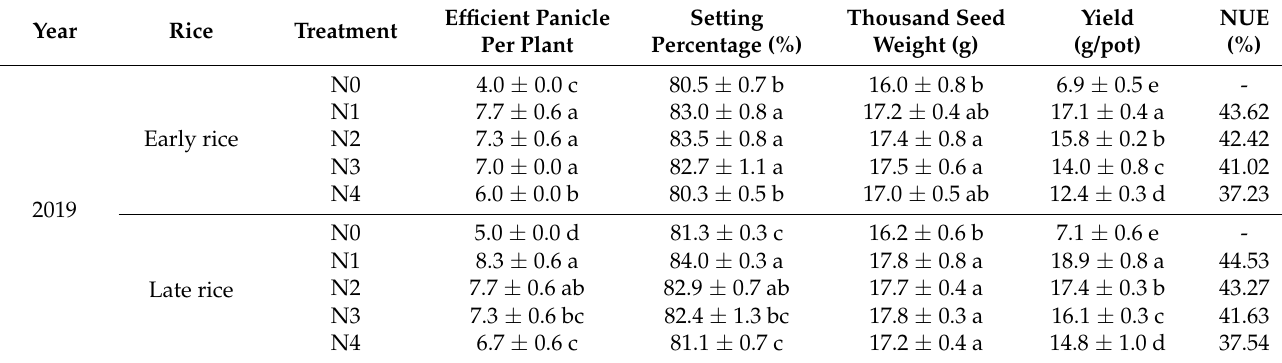
Table 1. Effects of N forms on N use efficiency (NUE) and yield of double-cropping